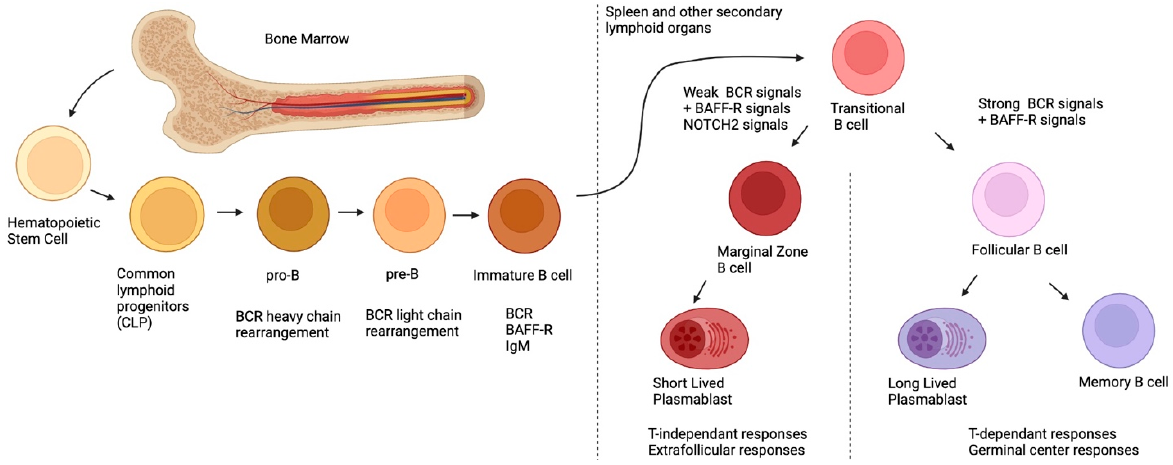
Figure 1. Ontogeny of postnatal B-cells.